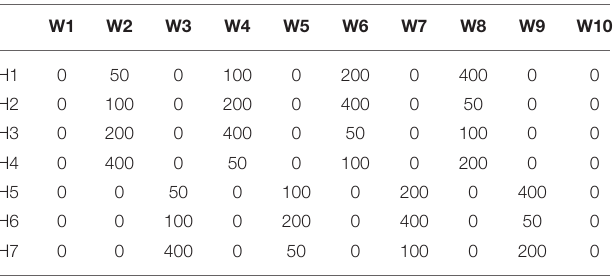
TABLE 2 | Latin square design of the